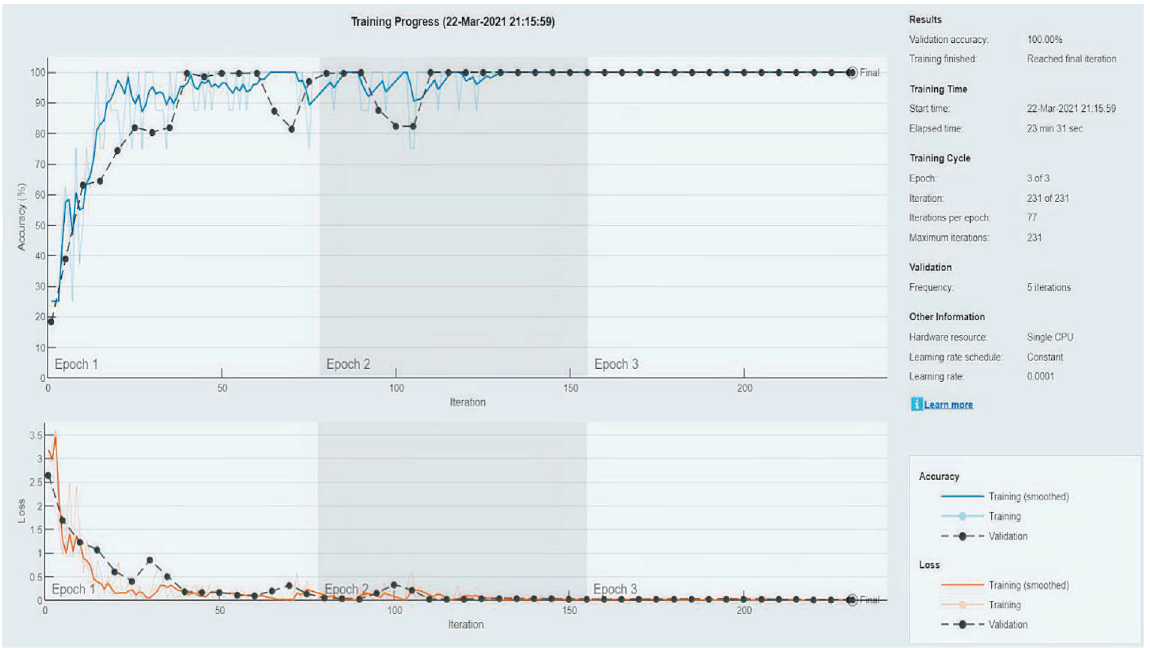
Figure 8: Training progress of finely tuned AlexNet.